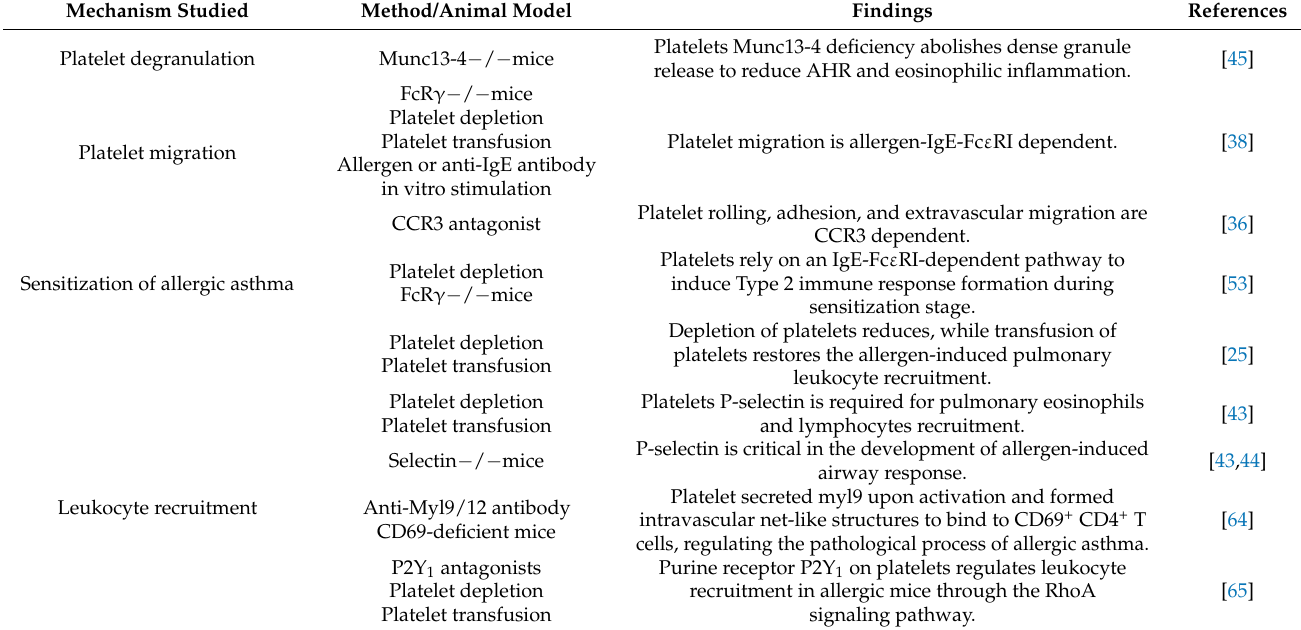
Table 2. Evidence of platelets’ involvement in the pathogenesis of allergic